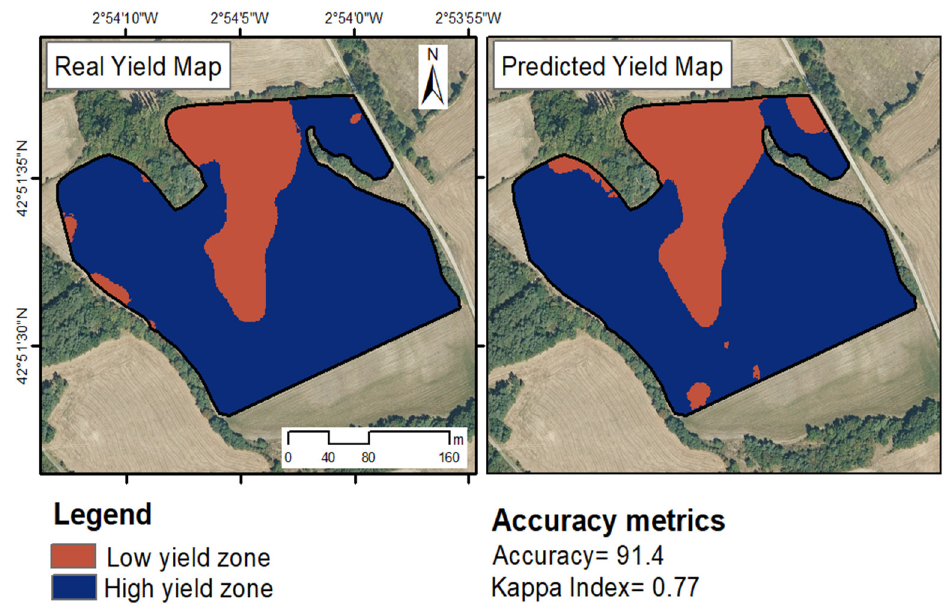
Figure 9. %MAE of the 39 plots when yield was predicted using the information from the rest of the plots. Those plots where %MAE is higher than 10% are shown in red. The dashed black line repre- sents the mean %MAE.